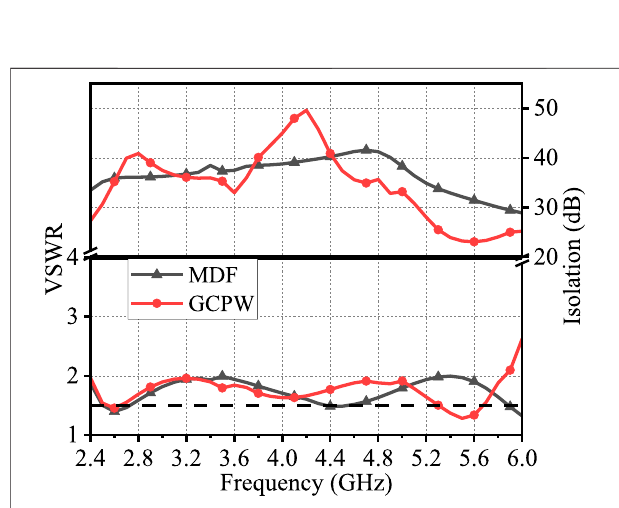
FIGURE 2 | Two wideband antennas. (A) Wideband antenna using the MDF structure. (B) The proposed antenna using the GCPW structure.